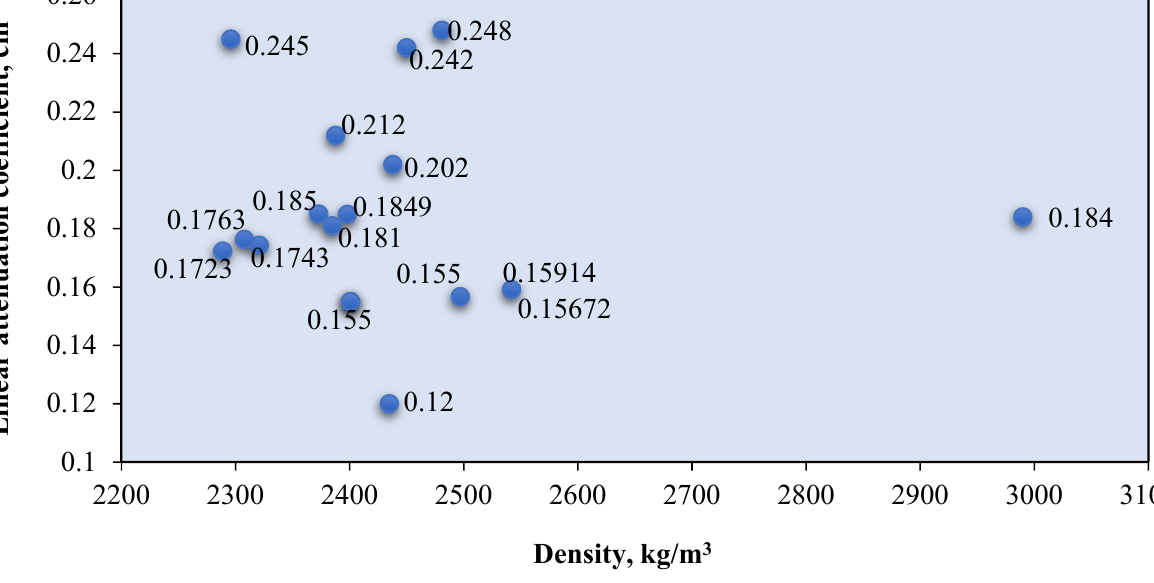
Figure 6. Relationship between linear attenuation coefficient and density of the sample containing natural aggregate (kg/m 3 ) (data adapted from [18,24,29,45,53,66,88,95,120,122,123]). A naturally occurring heavyweight aggregate has a bulk density of more 3000 kg/m 3 and includes barite, magnetite, hematite, limonite goethite, and ilmenite [76]. Figure 7 shows the relationship between the µ value and mass of the heavyweight aggregate per cubic meter of RSC. The value of µ is recorded based on exposure to gamma rays at 0.662 MeV. Recent research mostly used barite and magnetite in investigating RSC, as shown in Figure 4. Few studies used hematite, iron ore, siderite, and lead in the composition of RSC and recorded a maximum µ value of 0.22 cm − 1 [18,63,67,120,123].